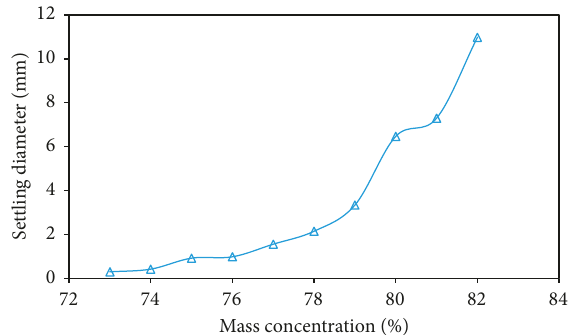
Figure 10: Calculation results of settling diameter at various mass